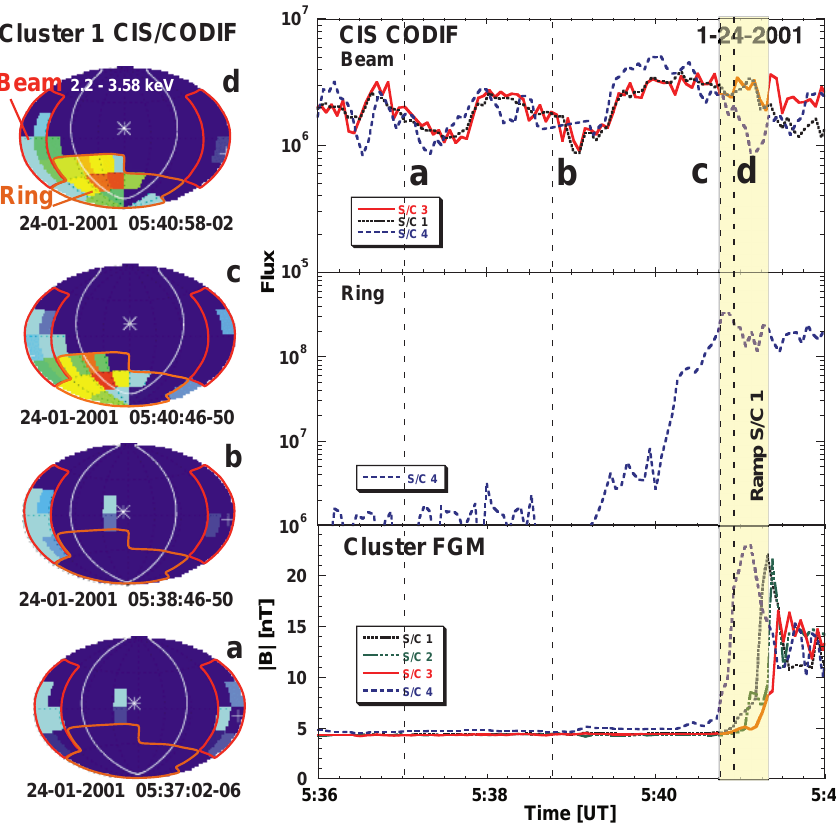
Fig. 4. Left column: Angular distributions as seen on spacecraft 1 in the shock ramp (d) , at the ramp edge (c) , and upstream of the shock (b), (a) . The angular regions of the beam (red) and ring (orange) are indicated. Right column: Integrated H + flux in the phase space portions that represent the beam from spacecraft 1, 3 and 4 (upper panel), reflected ring from spacecraft 4 (center panel), and magnetic field strength from all four spacecraft (lower panel). They are shown from approximately 5min before the bow shock encounter through the shock